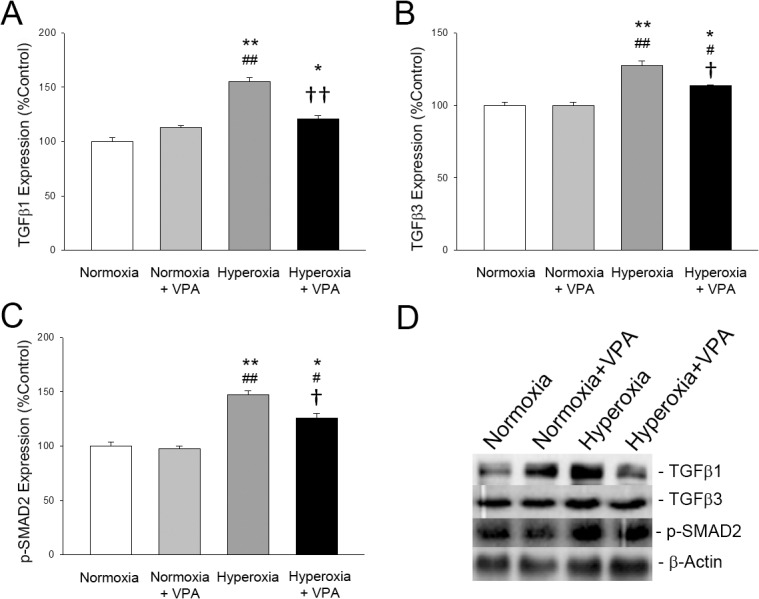
Bar graphs depicting TGFβ1 (A), TGFβ3 (B) and phospho-SMAD2 (C) expressions in lung tissues of rat pups.Panel D depicts representative bands for each protein, including β-Actin, the protein which was used as a loading control for western blotting. *p<0.05 and **p<0.001 compared to Normoxia group; #p<0.05 and ##p<0.001 compared to Normoxia+VPA group; and †p<0.05 and ††p<0.001 compared to Hyperoxia group using One-Way ANOVA followed by post-hoc Tukey test.